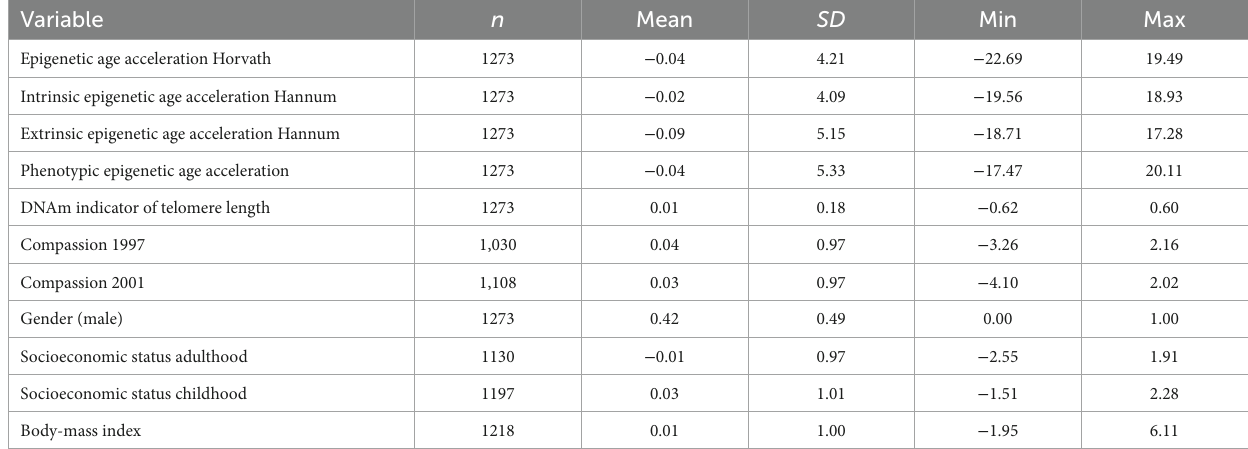
TABLE 1 Summary statistics of main study